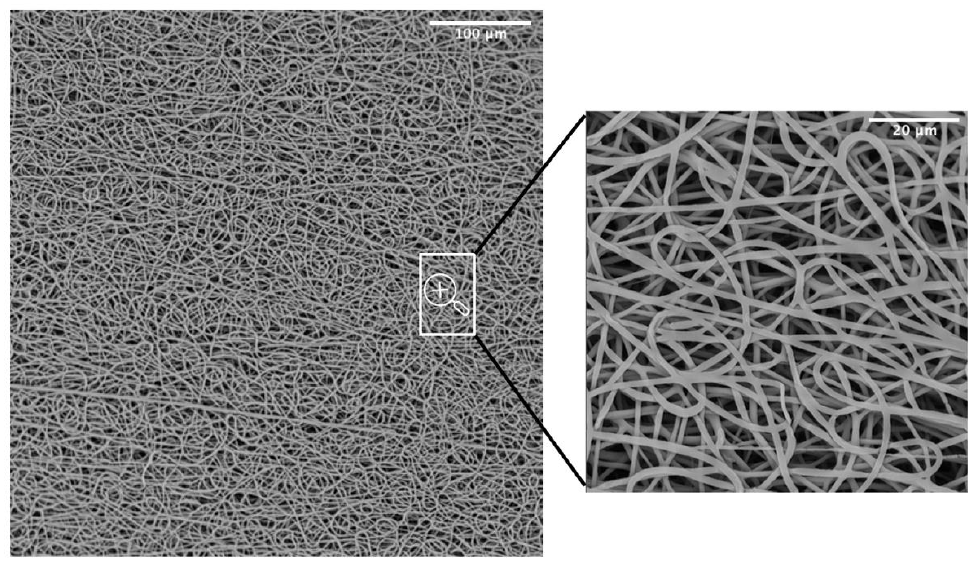
Figure 3. SEM micrograph of the PBS graft.